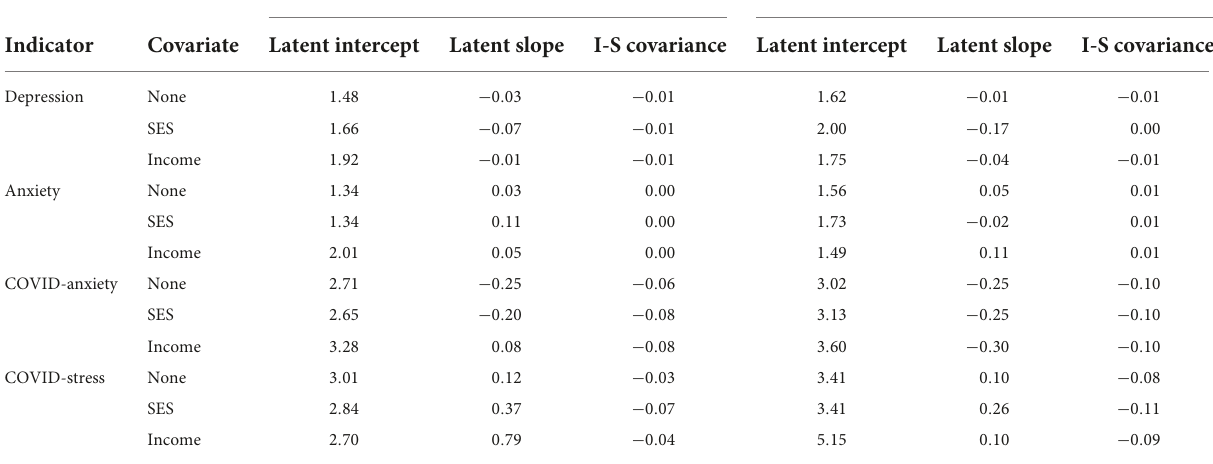
TABLE 4 Gender differences in (changes in) mental health